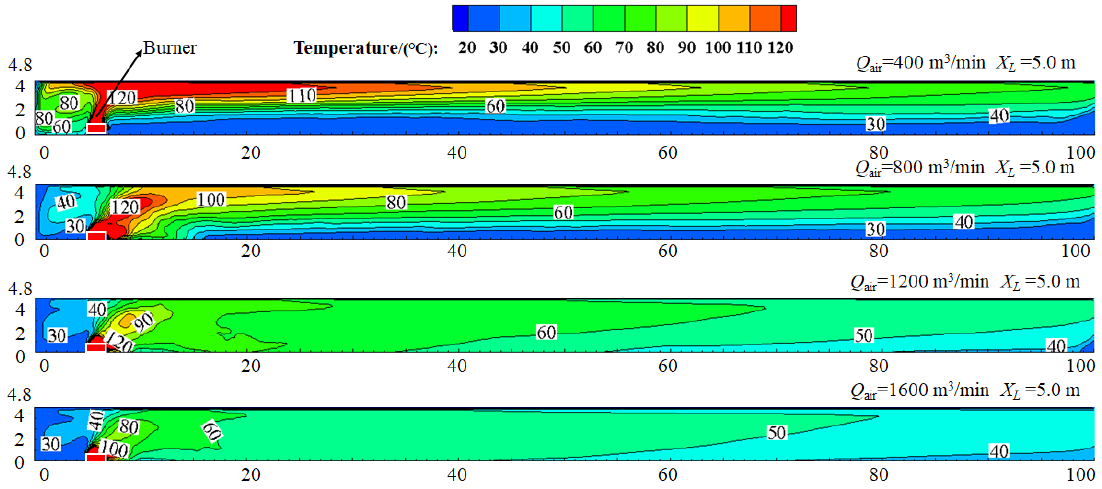
Figure 14. Longitudinal temperature distribution of the single-end tunnel.